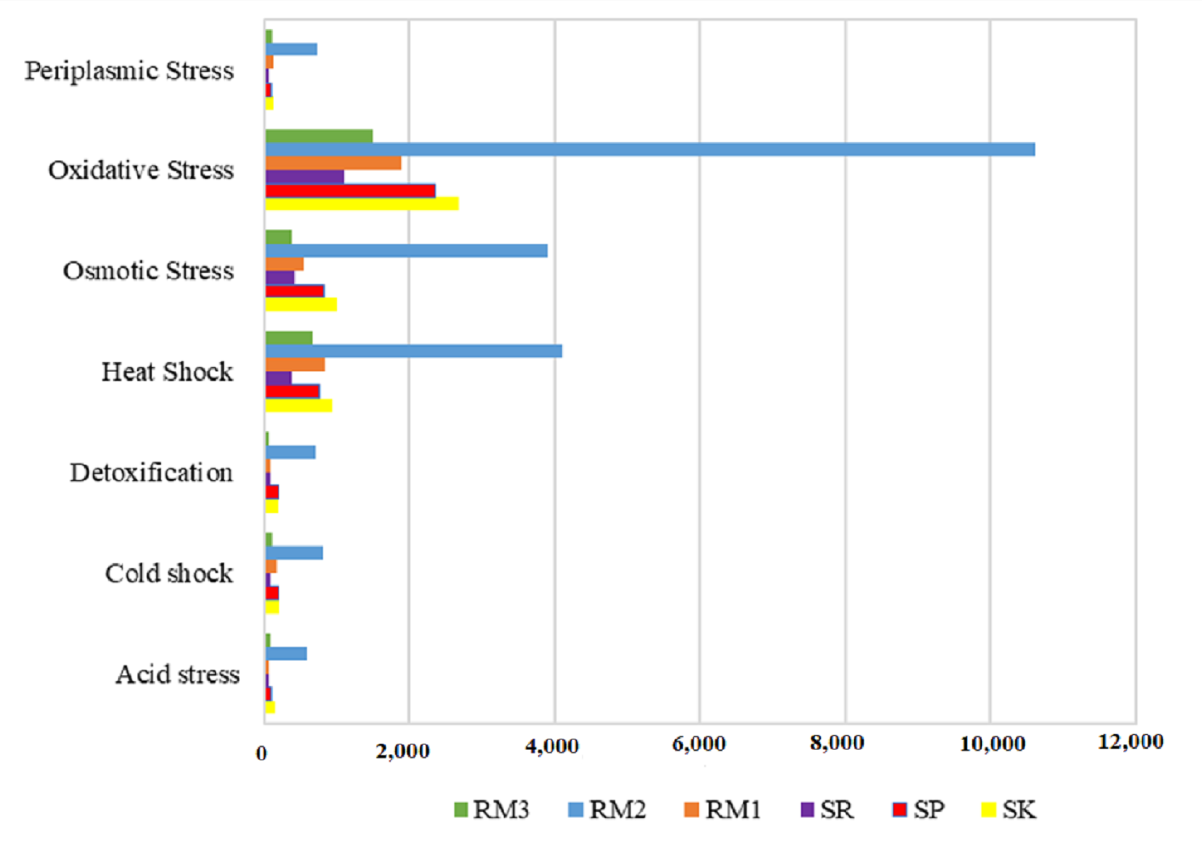
Figure 6. Gene abundances involved in the microbial-degradation pathways of acidic stress-re- sponse mechanisms by the WGS Shotgun. Taxonomic assignments for the Royal Belum (SK, SP, and SR) and Raja Muda Musa (RM1, RM2, and RM3) metagenomes were performed using MgRast .